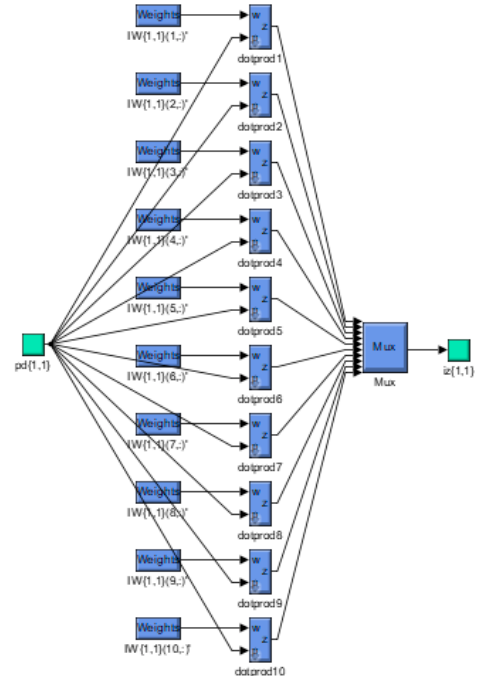
Figure 9. Structure of hidden layer artificial neural network used in this study.